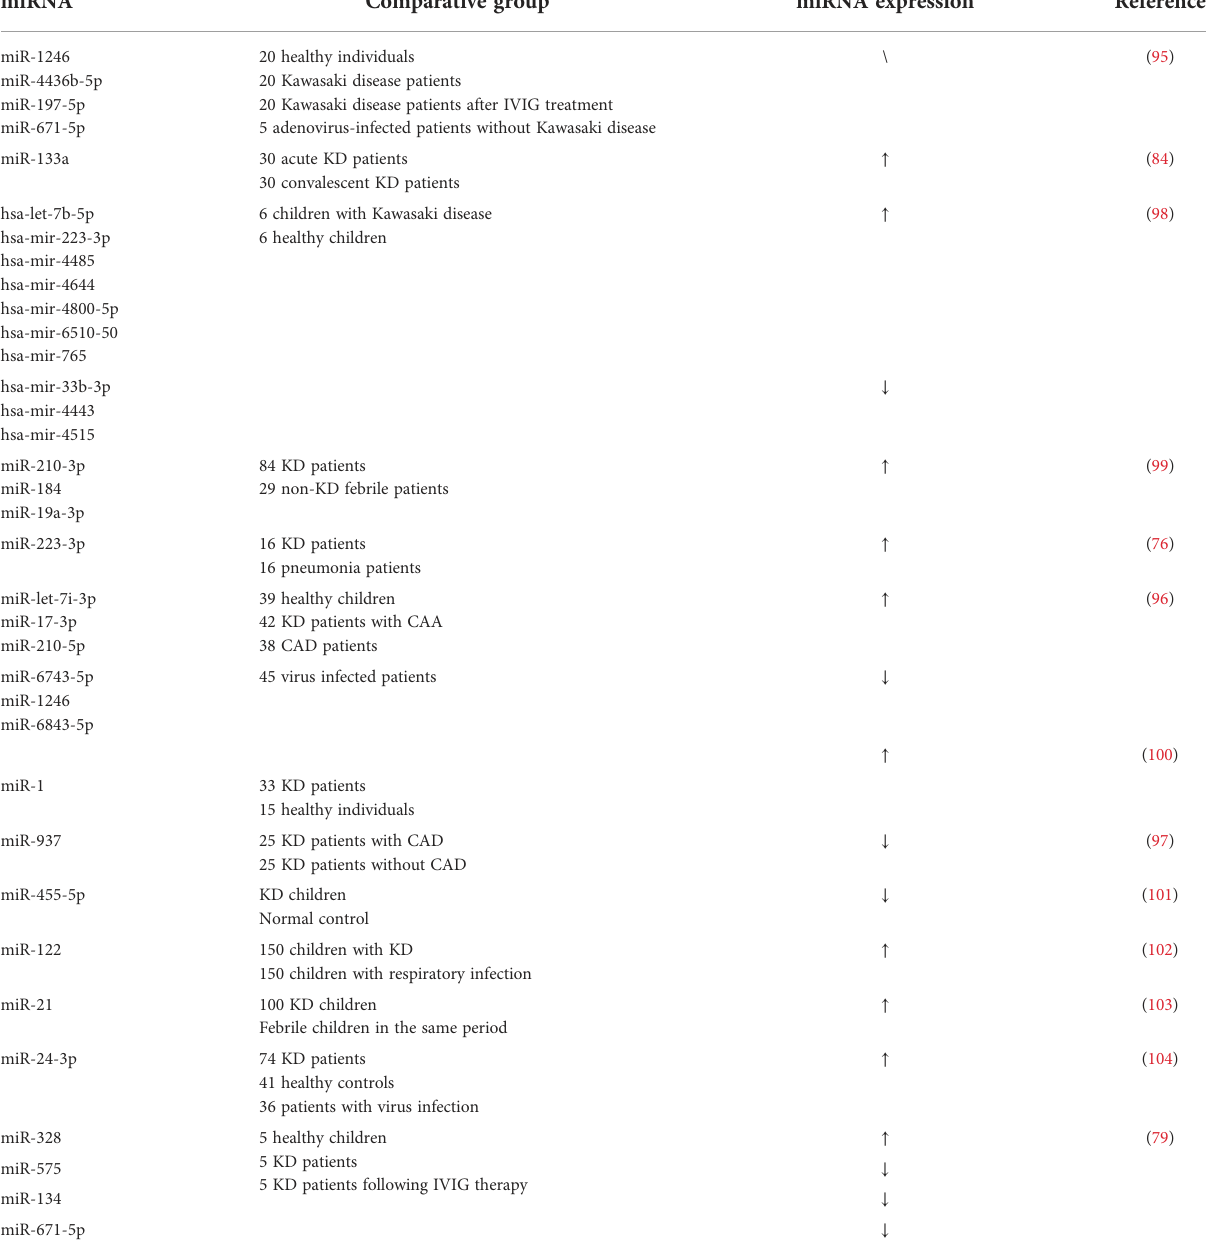
TABLE 2 MiRNAs as potential biomarkers for Kawasaki disease. miRNA Comparative group miRNA expression